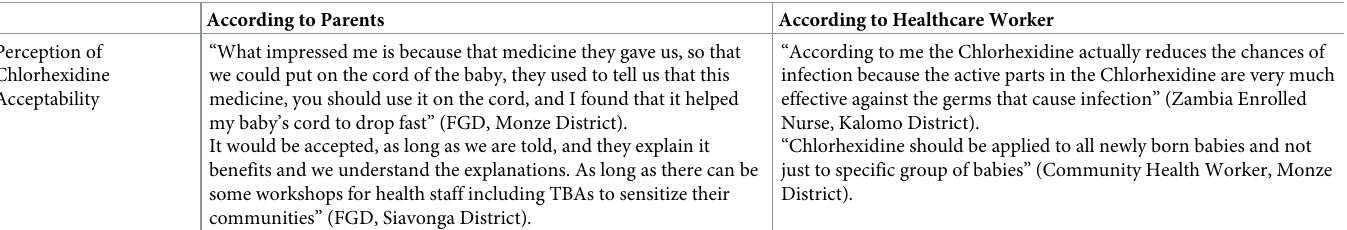
Table 4. Illustrative statements on chlorhexidine acceptability in ZamCAT. According to